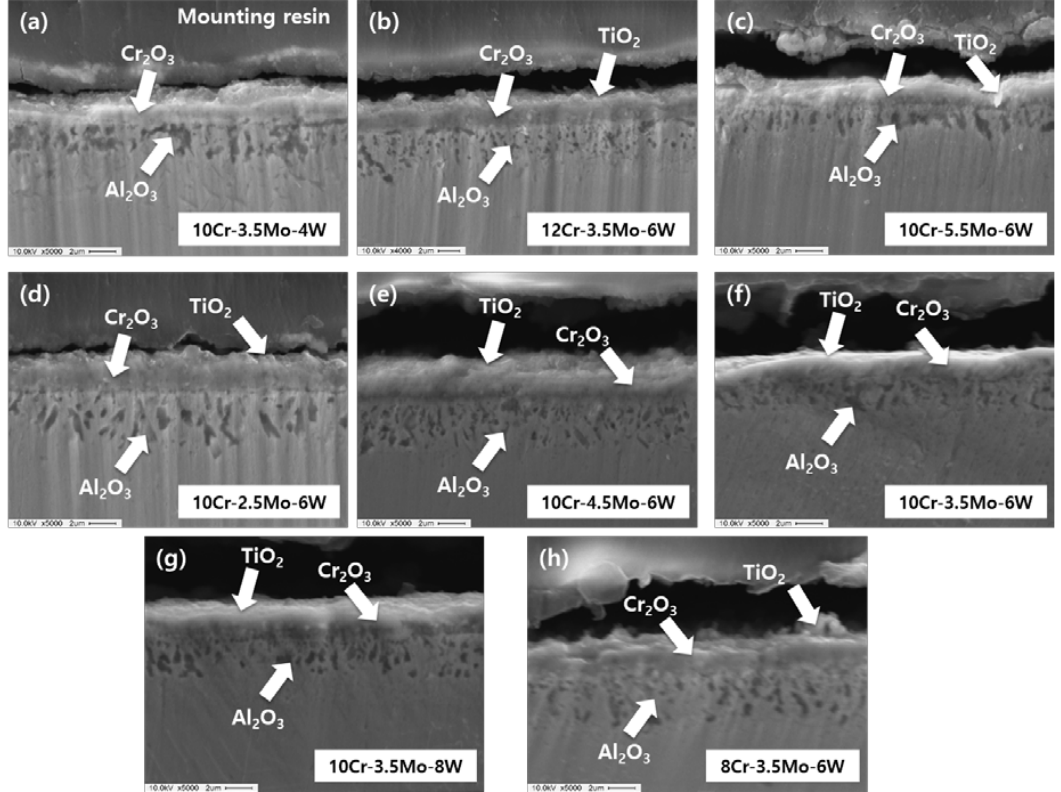
Figure 5. Cross-sectional image of ( a ) 10Cr-3.5Mo-4W, ( b ) 12Cr-3.5Mo-6W, ( c ) 10Cr-5.5Mo-6W, ( d ) 10Cr-2.5Mo-6W, ( e ) 10Cr-4.5Mo-6W, ( f ) 10Cr-3.5Mo-6W, ( g ) 10Cr-3.5Mo-8W, ( h ) 8Cr-3.5Mo-6W alloys oxidized at 850 °C.